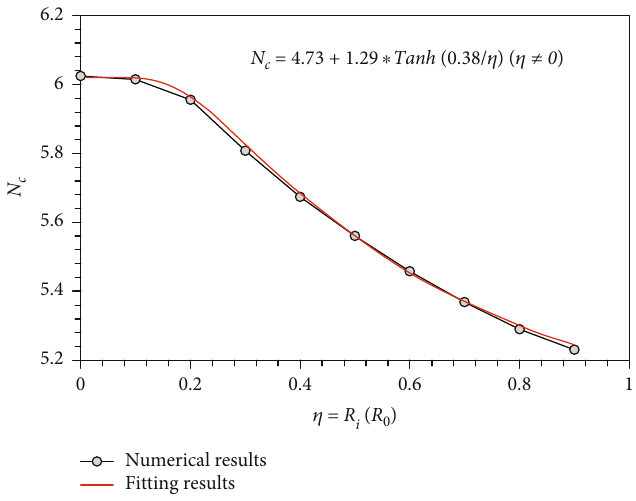
Figure 4: Variation curve of N